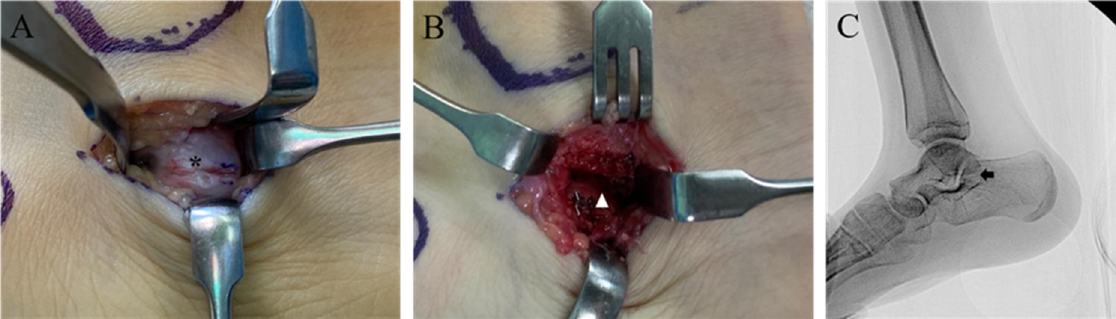
Figure 3. Resection of the talocalcaneal coalition in the right foot. ( A ) The talocalcaneal coalition (asterisk) is seen after retracting the posterior tibial tendon dorsally and flexor hallucis longus tendon plantarly. ( B ) The fibrocartilaginous coalition is excised (arrow head) using an osteotome and burr until the subtalar joint appears. ( C ) After resection of the talocalcaneal coalition, the C-shaped configuration is no longer seen (arrow) on the lateral radiograph.